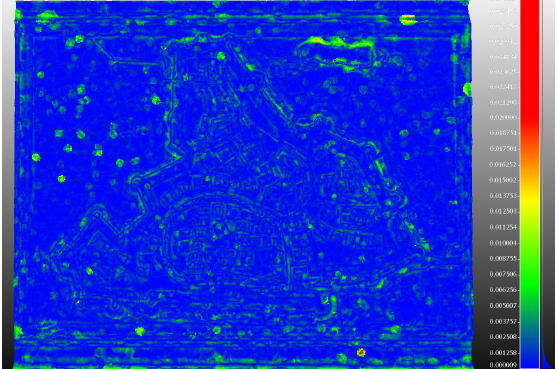
Figure 6. (a) Top view of “della Gatta” bastion, walls of Padova, Italy. Terrestrial laser scanner 3D reconstruction obtained with Leica ScanStation C10. (b) Inside view of the